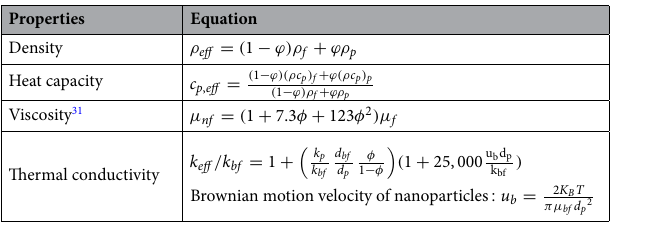
Table 1. Cu/water properties used in the simulations 12,13